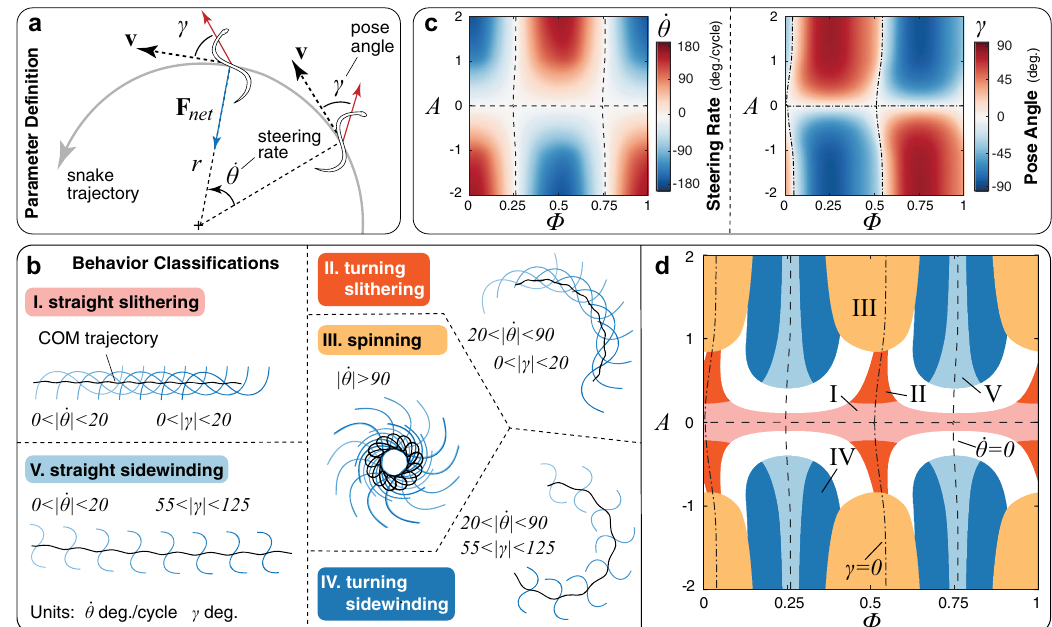
Fig. 2 Locomotory behaviors available to a snake as function of body lifting A and phase offset Φ . a Quantities used to analyze locomotion behavior. Steering rate _ θ is the time-averaged angular velocity of the snake ’ s center of mass. Pose angle γ is the angle between the snake ’ s orientation and velocity direction (Methods). b Classi fi cations of qualitatively different locomotion behaviors given _ θ and γ (Supplementary Movie 1), based on experimentally observed pose angles of sidewinding snakes 33 . Black lines are the snake ’ s center of mass (COM) trajectories. c Field map of steering rate _ θ and pose angle γ for varying lifting wave amplitude A and phase offset Φ (for μ μ = 2). d Phase space of locomotion behaviors available to a snake for the friction ratio μ t / f μ = 2. White spaces are transition regimes between different behaviors. Separatrices are zero contours for steering rate (dash line) and pose angle (dash- f dot line). All simulations employ ϵ = 7 and k = 1, as in 13